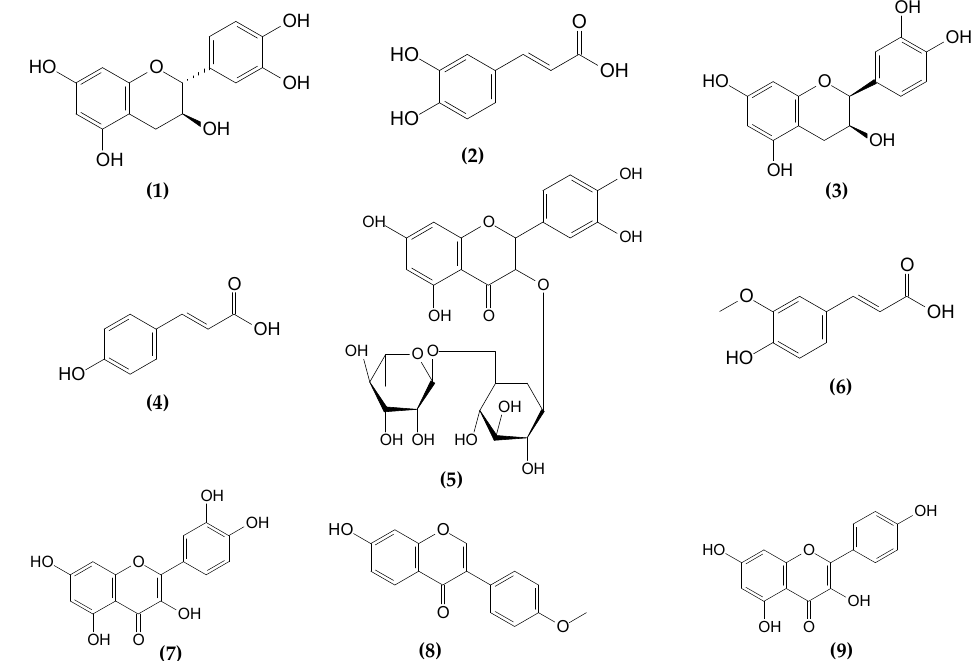
Figure 3. Structural formulas of phenolic compounds analyzed in Brazilian craft beers. ( 1 ) Catechin, ( 2 ) caffeic acid, ( 3 ) epicatechin, ( 4 ) p -coumaric acid, ( 5 ) rutin, ( 6 ) trans -ferulic acid, ( 7 ) quercetin, ( 8 ) kaempferol, and ( 9 ) formononetin.